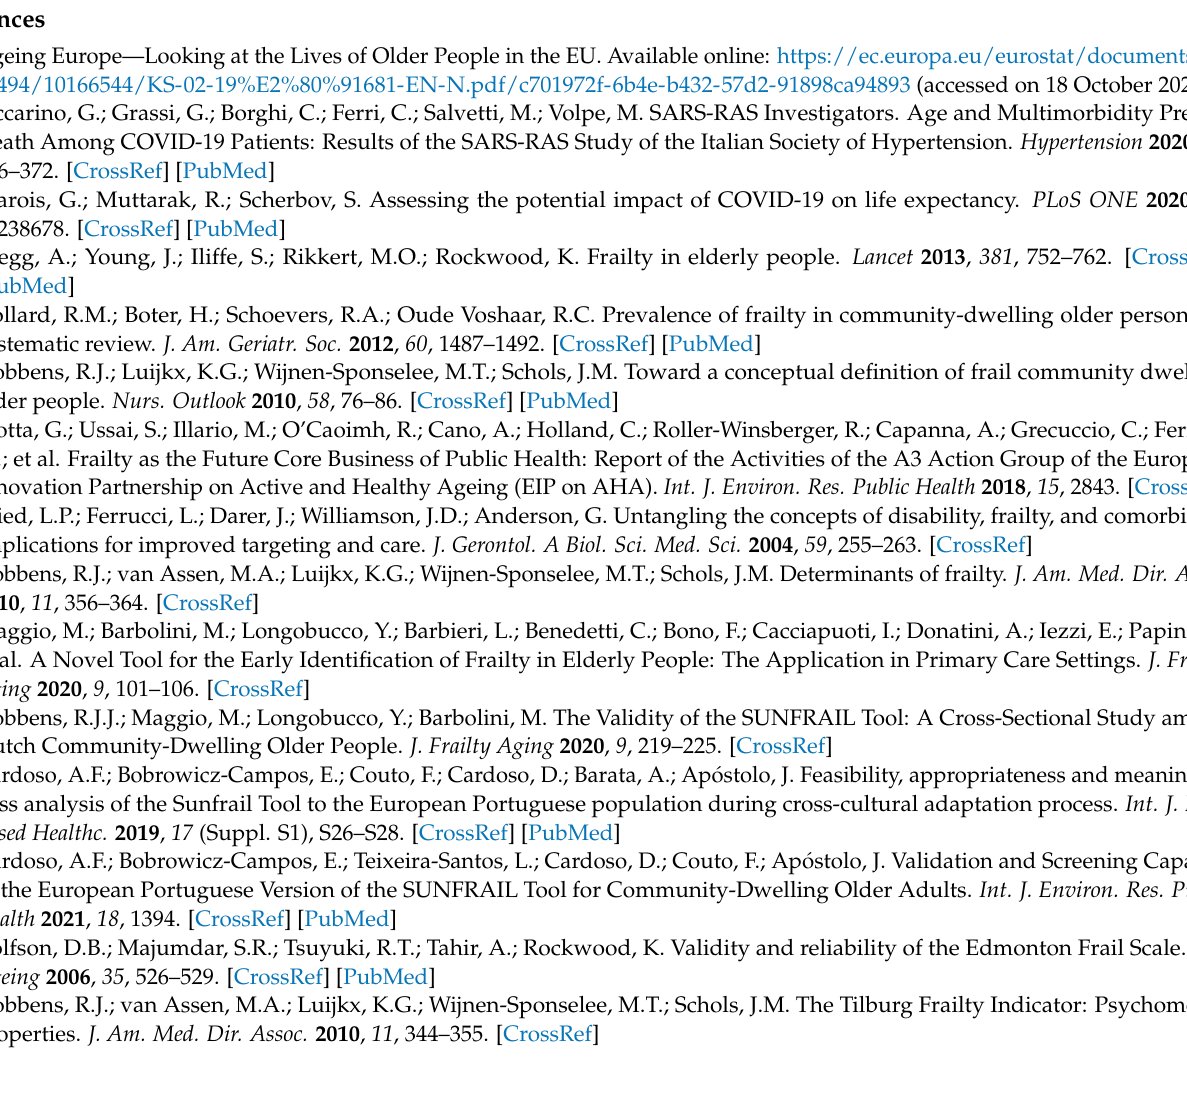
activity; Table S4: List of articles on fall and the risk of falling assessment tools; Table S5: List of articles on assessment tools for cognitive function; Table S6: List of articles on loneliness assessment tools; Table S7: List of articles on assessment tools for social support network. Refs. [142–306] cited in Supplementary